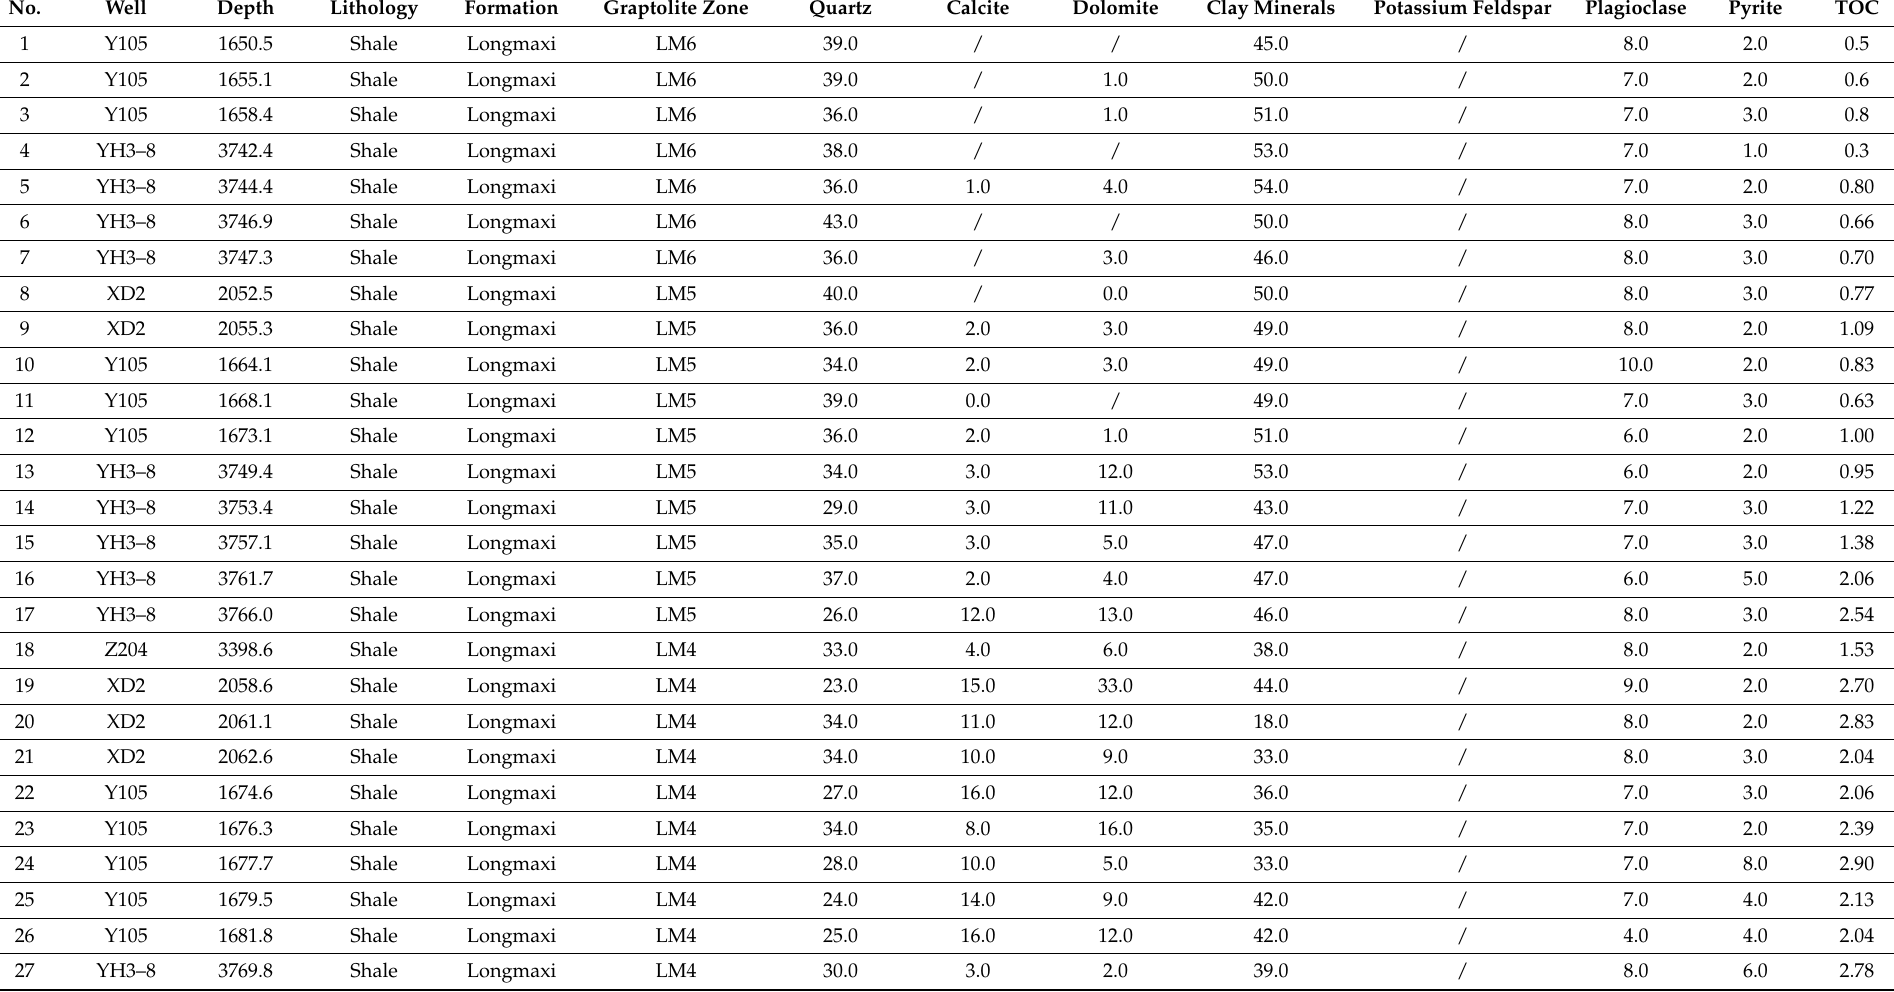
Table 1. Mineral compositions and TOC contents of the Wufeng–Longmaxi shale on the Yangtze Platform, South